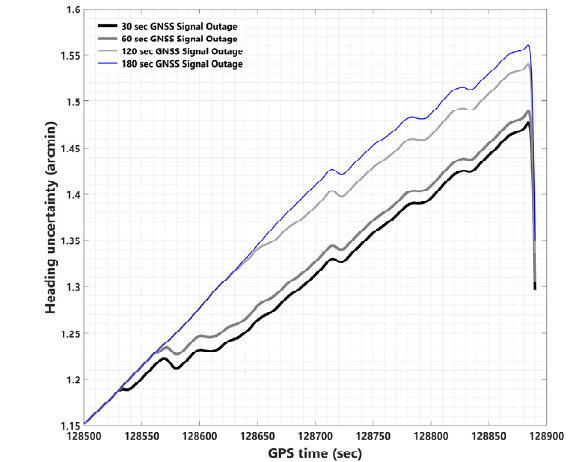
Figure 9. Uncertainties of heading using forward KF processing and assuming different GNSS outage durations.